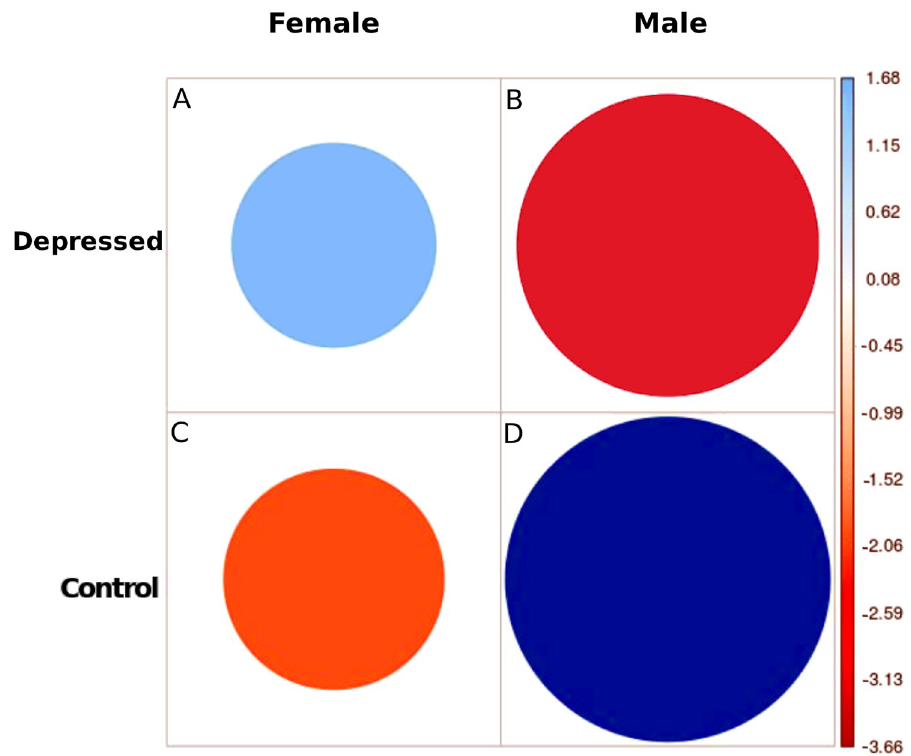
Fig 2. Gender and depressive behavior association (Chi-square test: Color-code: (blue:Association), (red: Repulsion), size: Amount of each cell’s contribution).